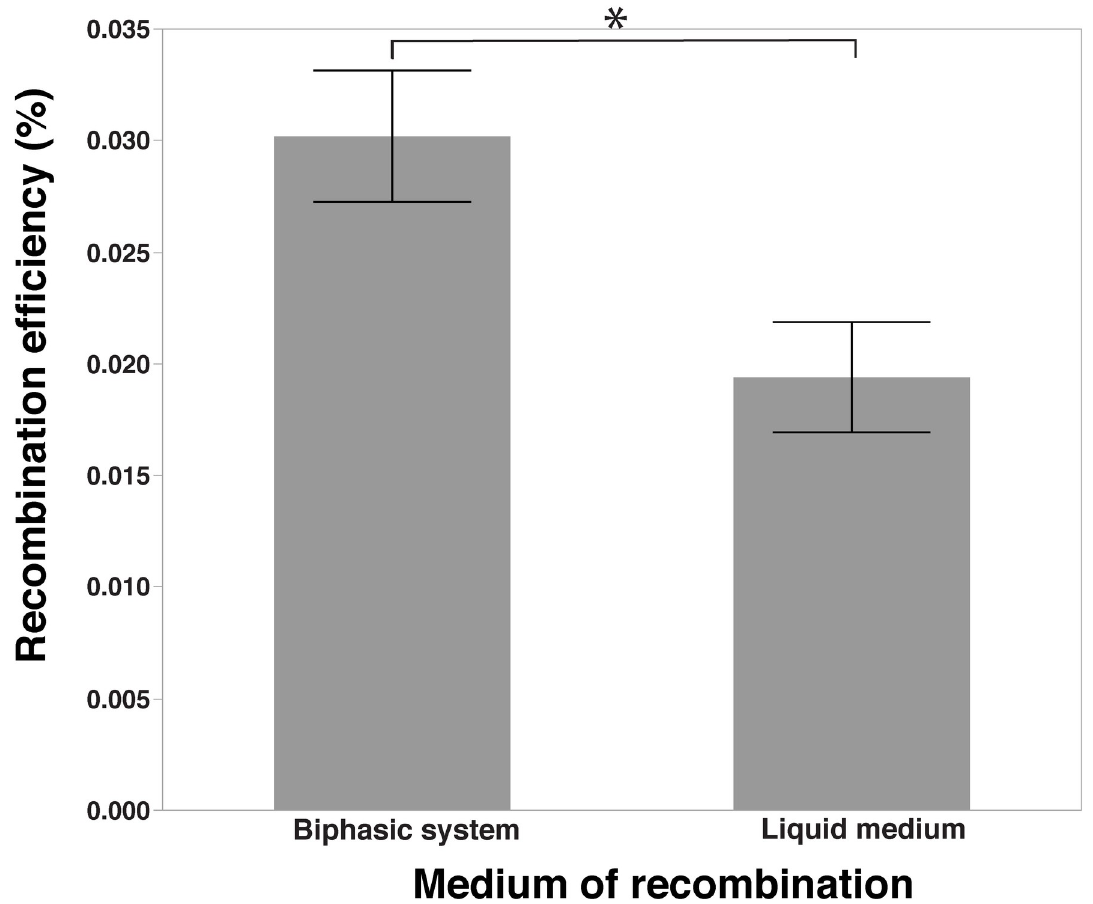
Fig 6. Comparison of the recombinant levels between biphasic medium vs. liquid medium. Recombinant levels expressed as percentage recombinants in the total number of parent cells; � indicates a significant difference at P < 0.05.